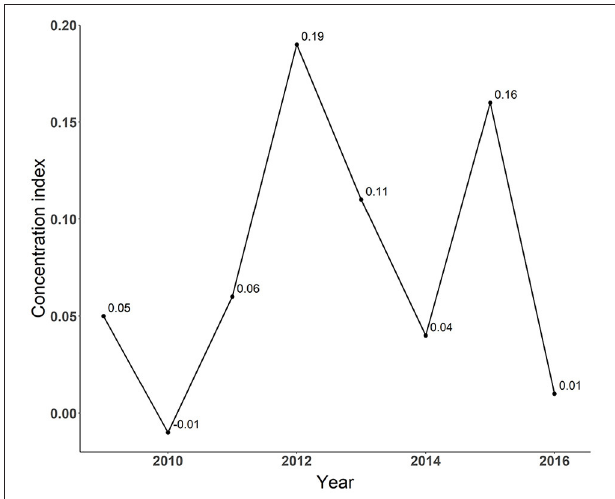
FIGURE 4 | Concentration index of government investment in hospital building construction.